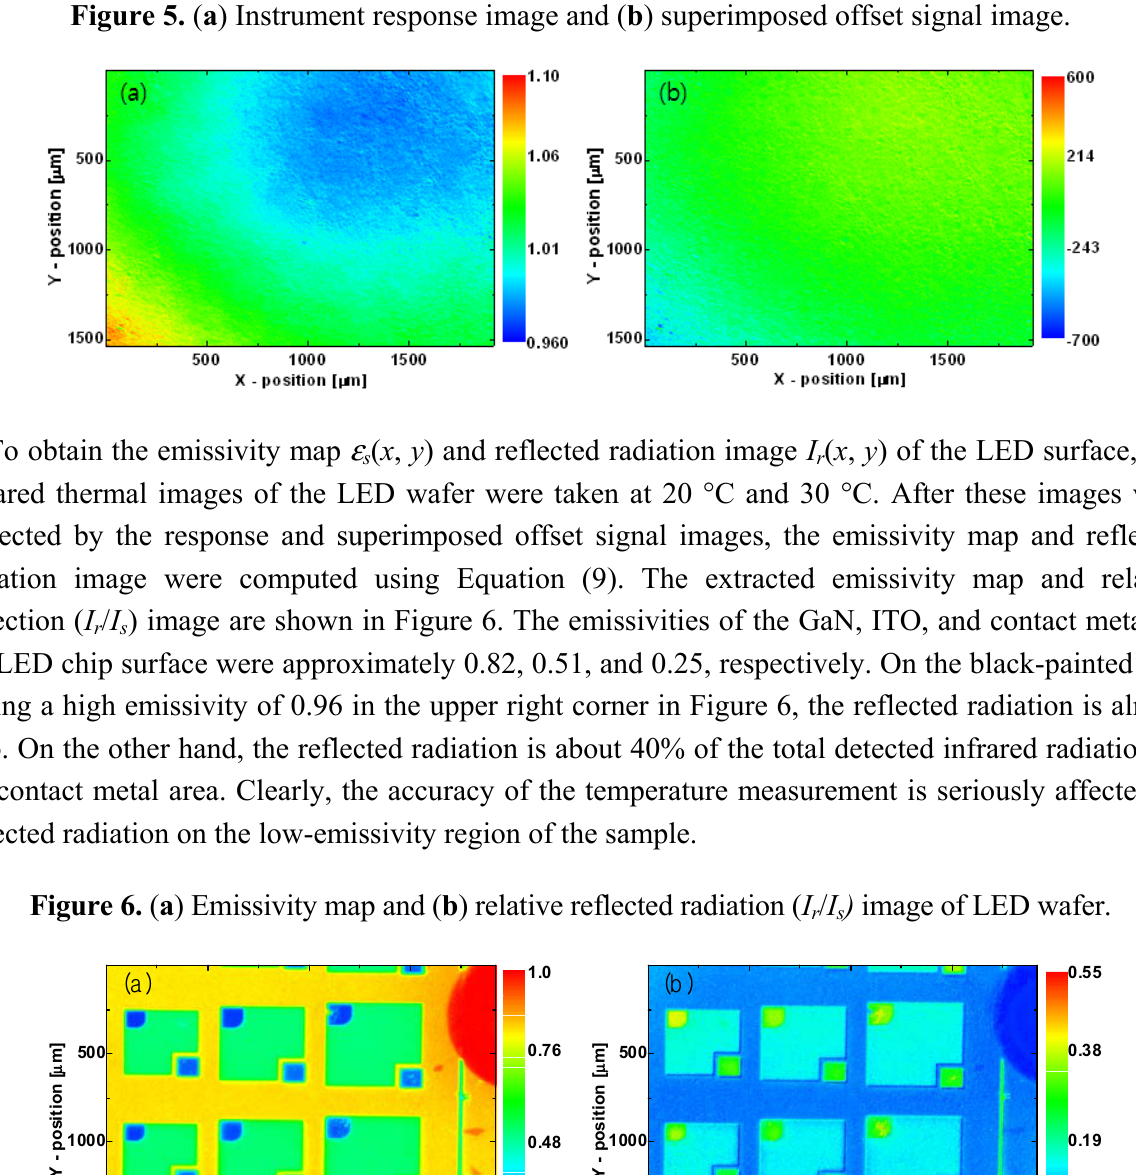
Figure 5. ( a ) Instrument response image and ( b ) superimposed offset signal image.